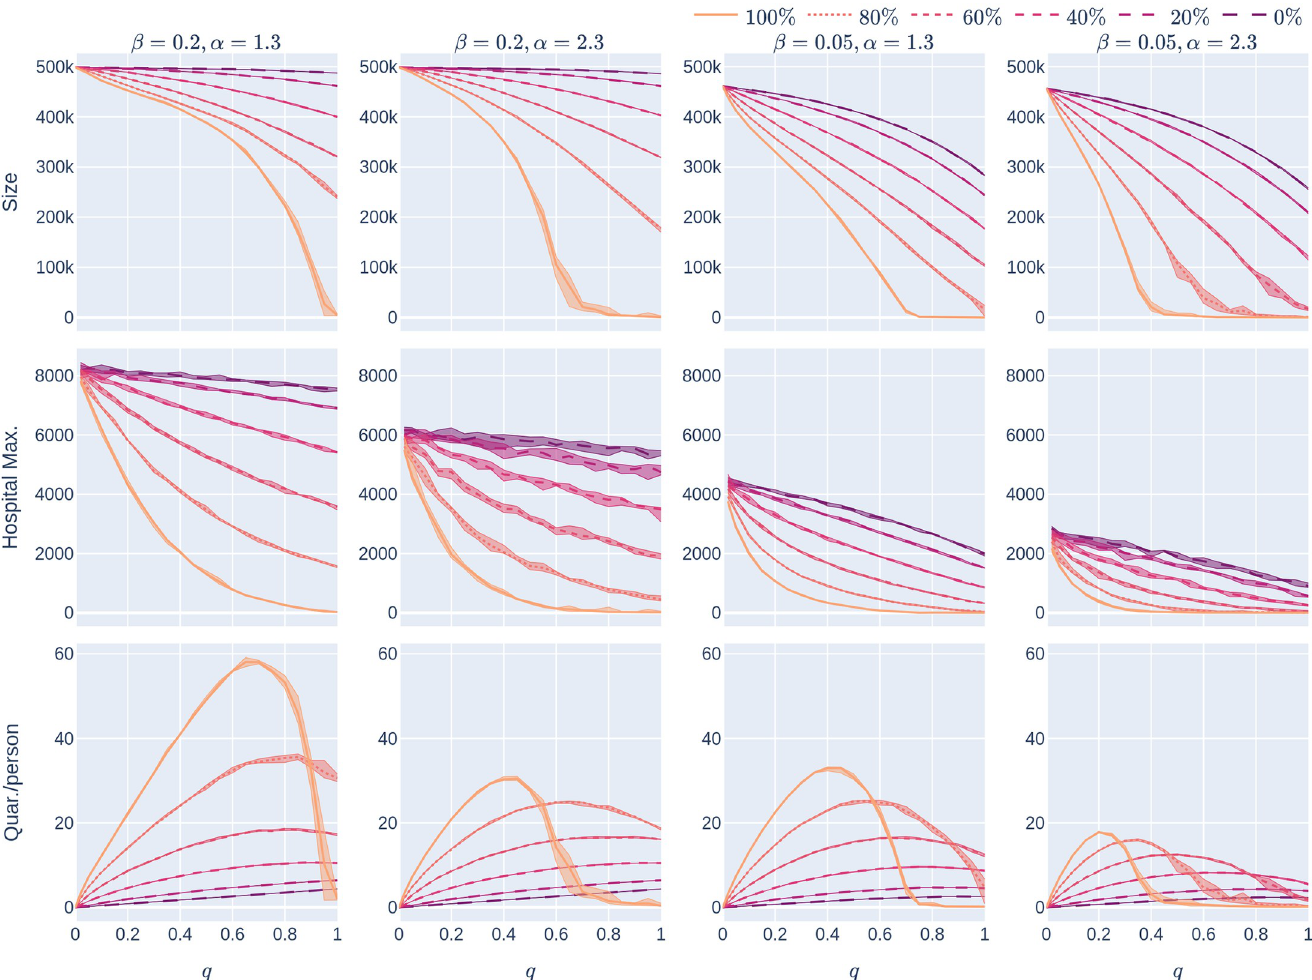
Fig 16. The effect of geometry and level of infectiousness on Experiment 2: The different curves correspond to different CTA uptake-rates ( p %), all in the random-uptake scenario in a 500,000-node GIRG with few super-spreaders ( τ = 3.3). The four columns represent different scenarios—the first column has β = 0.2 (a high infection rate, perhaps caused by less social distancing) and α = 1.3 (a less geometric network). The second column also has β = 0.2, but with more geometry ( α = 2.3). The final two columns represent scenarios with a lower underlying infection rate ( β = 0.05), with varying levels of geometry. The three rows correspond to the three KPIs. The x -axis shows the quarantine strictness q varying from 0 to 1 at step size 0.05. Simulations are done for the 21 values of q corresponding to these steps. There is an additional simulation point at 0.02 (in order to avoid division by 0 in the computation for HMax and still have a point close to 0). For each parameter value, the plotted result is the median over 5 runs. The shaded region around the plot covers the results of all 5 simulations. The epidemic is started by infecting 100 individuals, chosen uniformly at random. Simulation is halted when there are no more exposed or infected vertices.